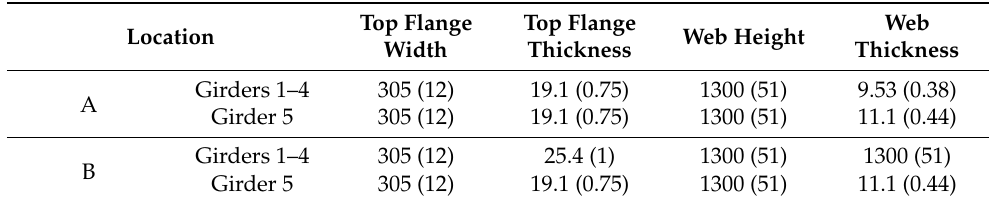
Table 1. Nominal section dimensions, mm (in.), at selected locations of bridge with web-and-flange sensor array.